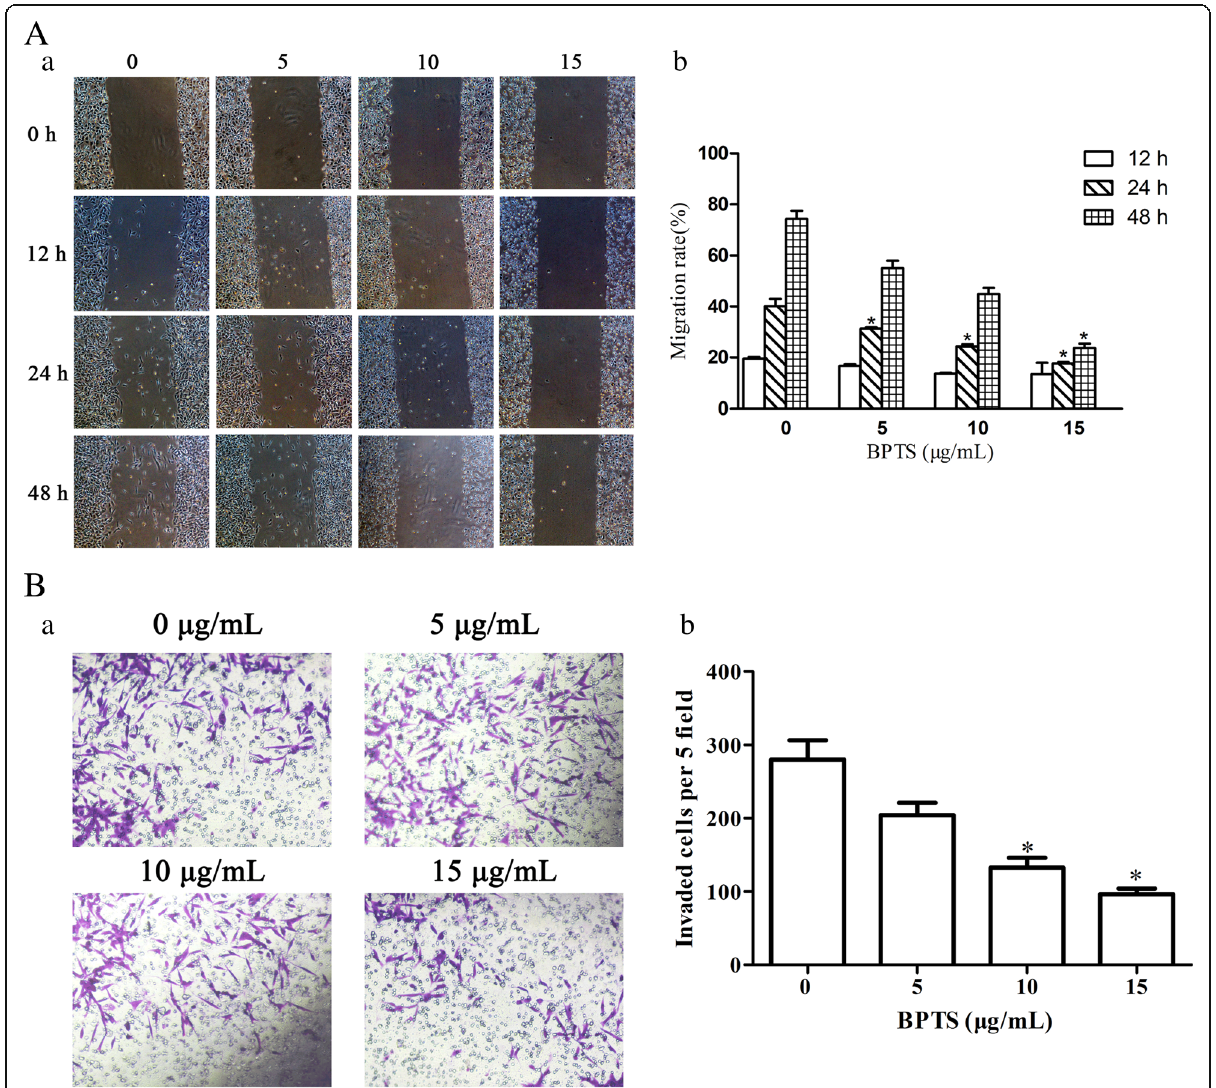
Fig. 4 Representative images from wound healing and transwell migration assays of cells treated with BPTS were obtained after treatment with different concentrations of BPTS. ( a ) Representative image of the wound-healing and transwell migration assays. ( b ) Quantification of wound healing and transwell migration rate. * P < 0.05 vs. 0 μ g/mL of